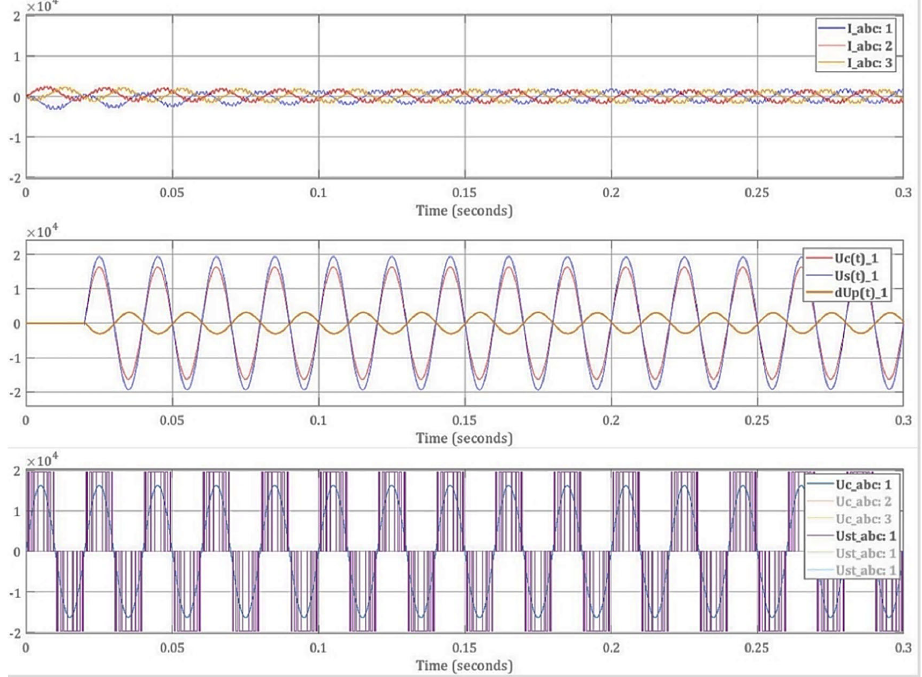
Figure 11. α = 0°, kUst = 1.2—active power consumption and reactive power generation.